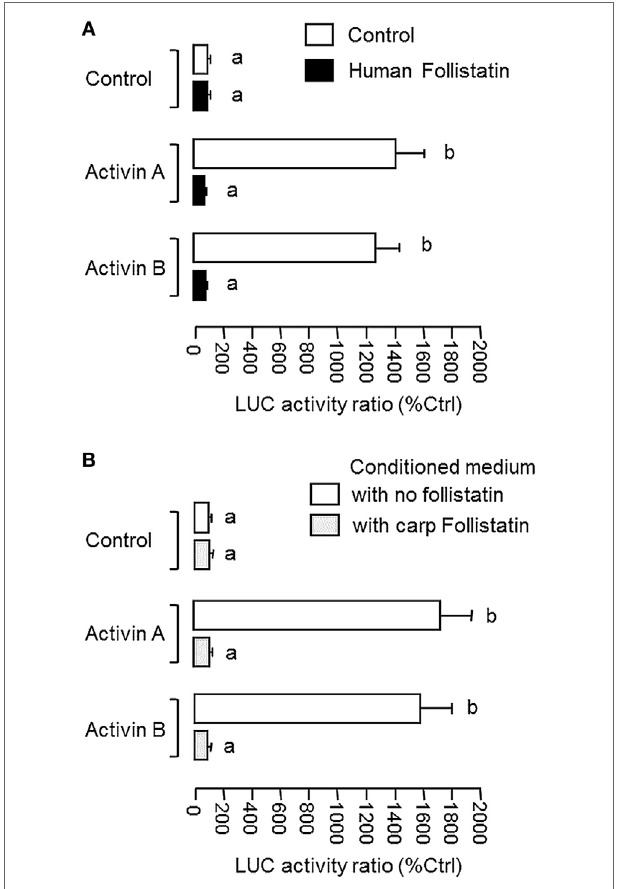
FigUre 2 | Functional characterization of carp follistatin in α T3 cells. (a) Validation of follistatin blocking of activin’s action in α T3 cells with pAR3-Lux transfection. In this experiment, α T3 cells were transfected with the pAR3-Lux reporter with 5 ′ promoter carrying tandem repeats of activin- responsive elements and challenged for 24 h with human activin A (10 ng/ml) and B (10 ng/ml), respectively. In treatment group, activin A and B induction were conducted in the presence of human follistatin (100 ng/ml). (B) Grass carp follistatiin on activin-induced pAR3-Lux reporter activity expressed in α T3 cells. Conditioned medium obtained from CHO cells transfected with the expression vector for carp follistatin was used as the source of follistatin of carp origin. For functional testing of carp follistatin, α T3 cells transfected with pAR3-Lux were challenged for 24 h with activin A (10 ng/ml) and B (10 ng/ml) in the presence of the conditioned medium containing carp follistatin. Parallel incubation with conditioned medium harvested from CHO cells transfected with the blank vector pcDNA3.1 was used as the control treatment. In these experiments, cell lysate was prepared from α T3 cells after activin treatment (with/without follistatin) and used for luciferase activity measurement with a Dual-Glo ® assay kit. Data presented are expressed as mean ± SEM ( N = 6) and the groups denoted by different letters represent a significant difference at P < 0.05 (ANOVA followed by Newman–Keuls